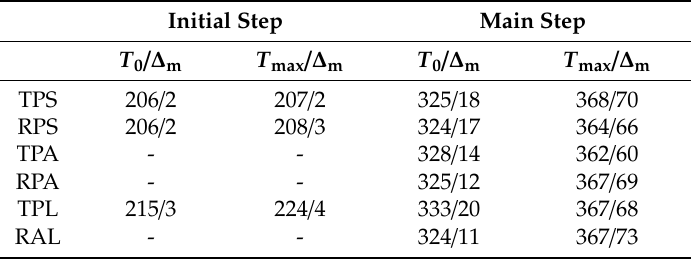
Figure 6. TG and DTG curves of PMMA samples before artificial aging. Curves obtained at a heating rate of 10 °C/min, under a N 2 atmosphere. Table 6. Thermal parameters obtained from the TG and DTG curves of the different PMMA samples, including onset temperature ( T 0 ) and maximum process rate temperature ( T max ) in °C, and respective mass losses ( ∆ m ) in % of original mass, for the two thermo degradation steps observed.